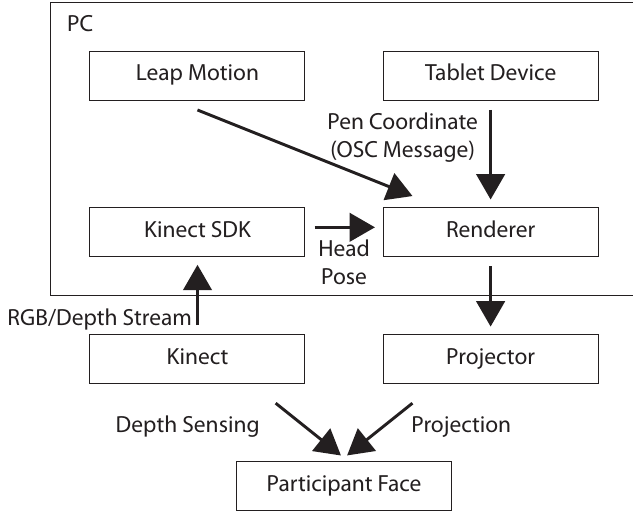
Fig. 10. A flowchart of the